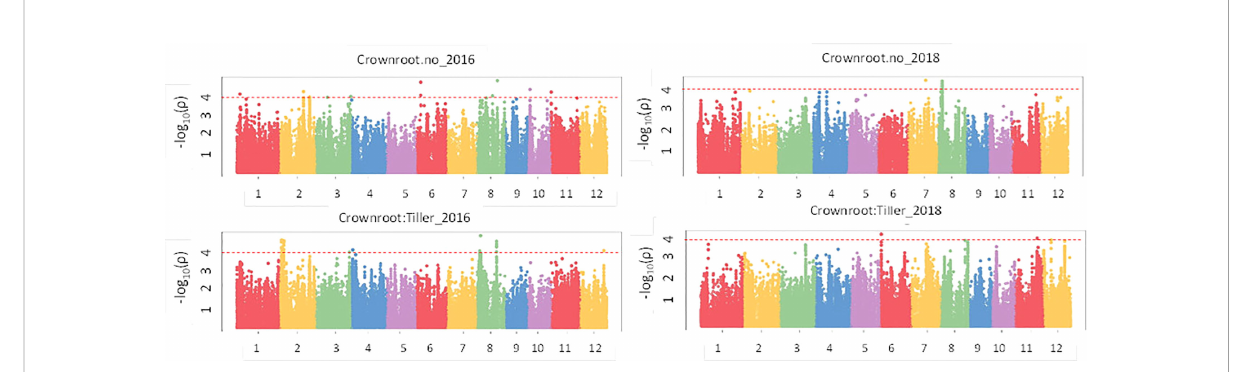
FIGURE 5 GWAS results for crown roots in puddled, transplanted (2016WS; left) and direct seeded (2018WS; right) trials on the Thai/SE Asia panel. WS, wet season.